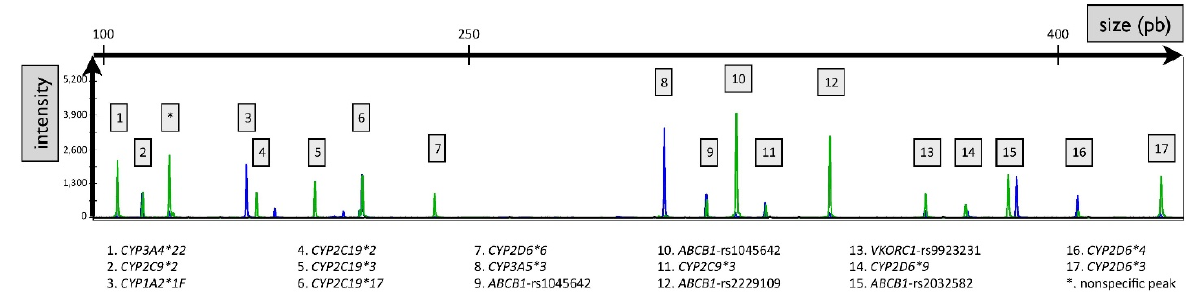
Figure 1. Resolution of the 17 amplicons corresponding to the clinically relevant genetic polymorphisms. Example of an electrophoregram obtained for one DNA sample. The green peaks correspond to the fluorescence of the HEX probe. The blue peaks correspond to the fluorescence of the FAM probe.